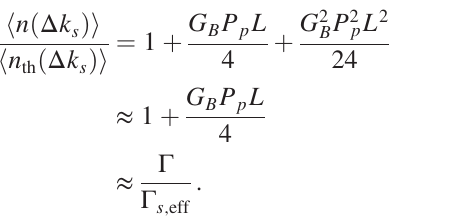
FIG. 4. Theoretical fractional phonon occupation [numerical integration of Eq. (A18)] as a function of the device length. 470 W − 1 m − 1 , P 1 W, and For the calculated curve G B ¼ p ¼ Ω 2 π × 6 . 02 GHz — parameters that may be accessible in B ¼ silicon optomechanical waveguides at mid-IR wavelengths. We P L ≫ 1 ), note that at large gain-power-length products (i.e., G B p the Stokes light must be suppressed or removed from the system to avoid pump